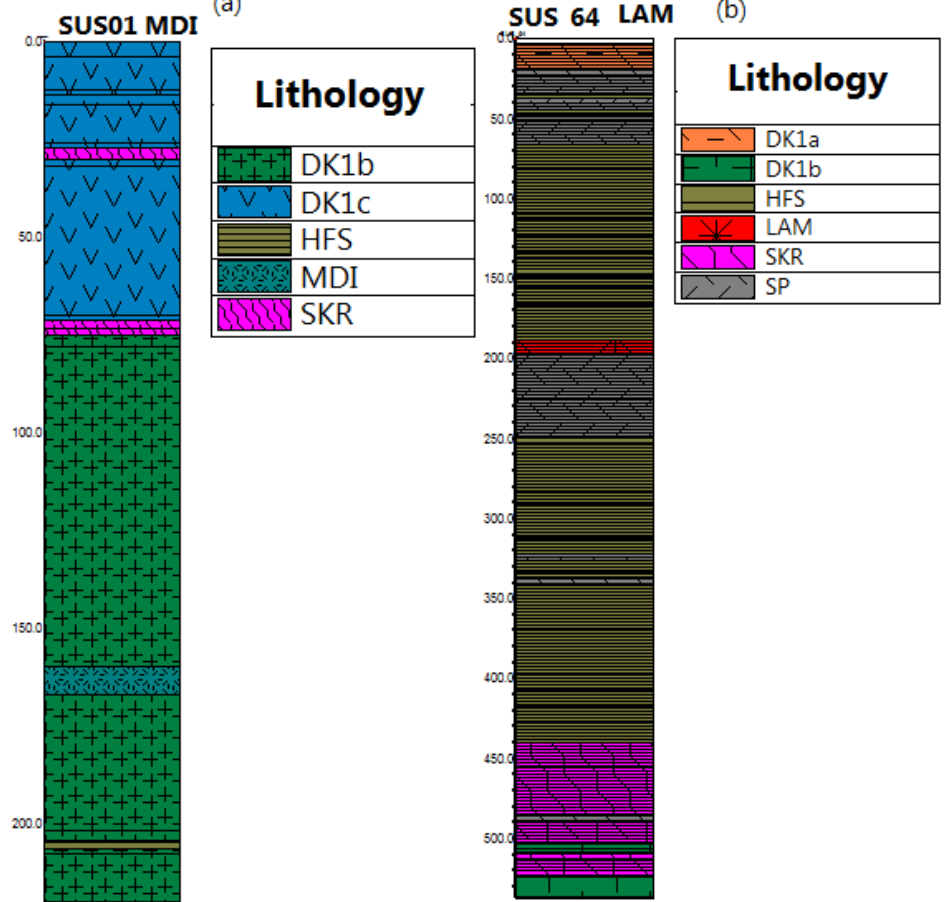
Figure 6. Two Sungun mine drill core logs representative of the diversisty of lithologies. ( a ) Core SUS01 contains a microdioritic dyke and ( b ) core SUS64 contains a lamprophyric dyke that have no surface exposure. SP is Sungun porphyry; DK1a, b and c are three phases of quartz dioritic dykes; DK2 is gabbrodiorite; DK3 is diorite; DK4 is dacite; MDI is a microdioritic dyke; LAM is a lamprophyric dyke; SKR is skarn; and HFS is hornfels.